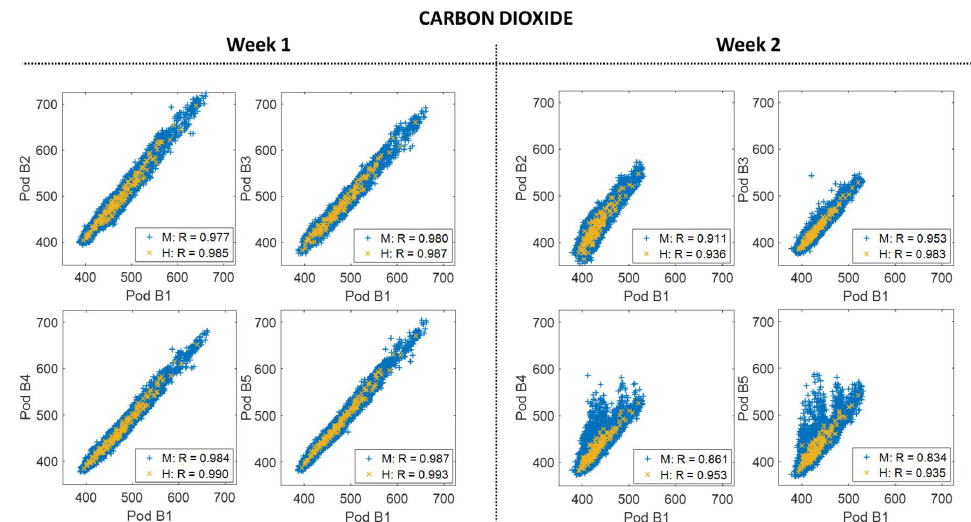
Figure 5. The scatter plots to the left show the correlation between Y-Pod B1 and each of the added building Y-Pods (B2, B3, B4, and B5) for both minute (M) and hourly (H) CO 2 data for Week 1 (co-located). The scatter plots to the right show the same correlations, again with minute and hourly data, but for Week 2. Sensors 2018 , 18 , x FOR PEER REVIEW